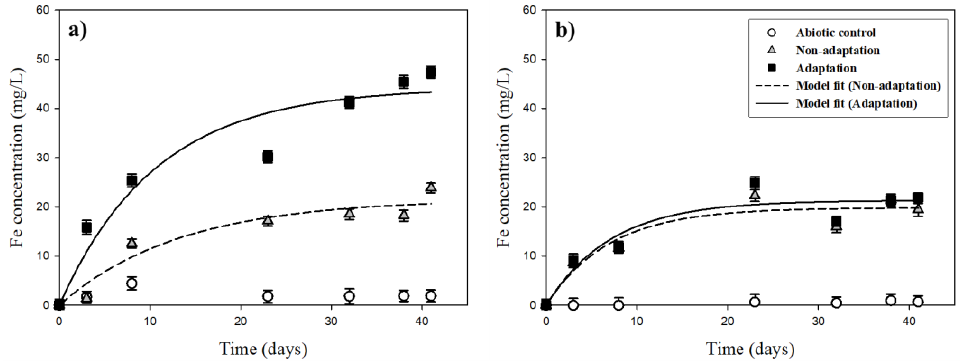
Figure 8. Variation of Fe concentrations during bioleaching experiments under different initial pH conditions: ( a ) pH ini 2.8; ( b ) pH ini 3.2. Elzeky and Attia [27] performed bioleaching experiments using pyrite (FeS 2 ), chal- copyrite (CuFeS 2 ), and arsenopyrite (FeAsS) using non-adapted and adapted bacteria, and they reported a higher performance of metal recovery (3.43 times for Cu and 1.65